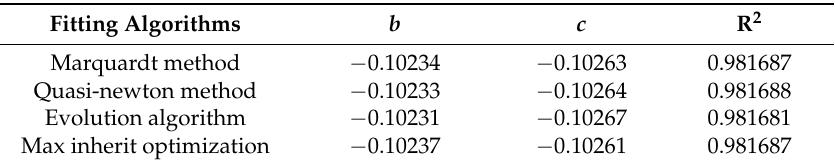
Table 10. Parameters b and c using different fitting